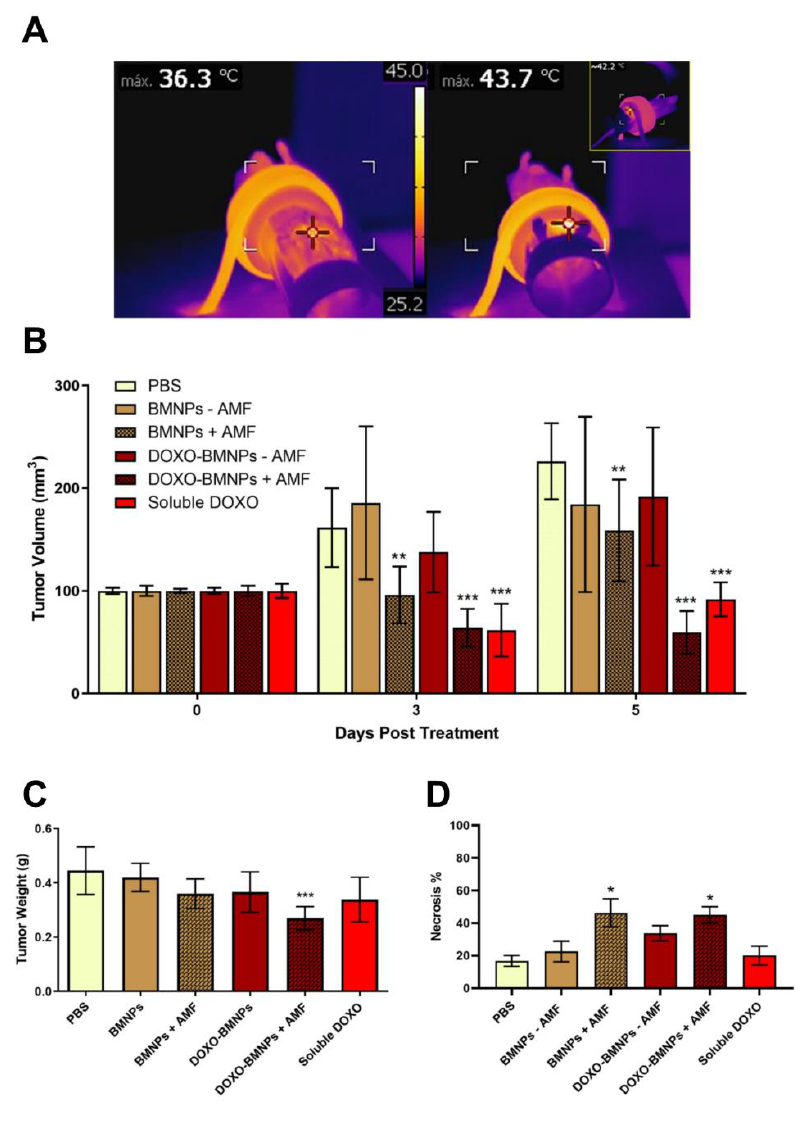
Figure 7. In vivo antitumor activity of BMNPs under the influence of an alternating magnetic field (AMF): ( A ) Images taken with a thermic camera of a representative mouse without (left) and with (right) injected BMNPs during AMF treatment. Note the di ff erent colors within the circle on the backside of the mouse. ( B ) E ff ect on the growth of 4T1 tumors ( n = 8) in female BALB / c mice, analyzed 3 and 5 days after one single injection of DOXO-BMNPs or not functionalized BMNPs ± AMF: Each group received one intratumor injection of 3 mg BMNPs / mouse on the first day of the treatment (day 0). For the groups injected with soluble DOXO or DOXO-BMNPs, the dose of DOXO (either soluble or adsorbed on the BMNPs) was 80 µ g / mouse. Di ff erences between groups (all compared to PBS) were assessed by 2-way ANOVA with Dunnett’s multiple comparison test (*** p < 0.0001; ** p = 0.001). Weight ( C ) and necrosis % ( D ) of tumors were measured at the end of the experiment (day 5), and all samples were compared to the PBS group. Di ff erences between groups were assessed by ordinary one-way ANOVA with Dunnett’s multiple comparison test (*** p < 0.05; * p =